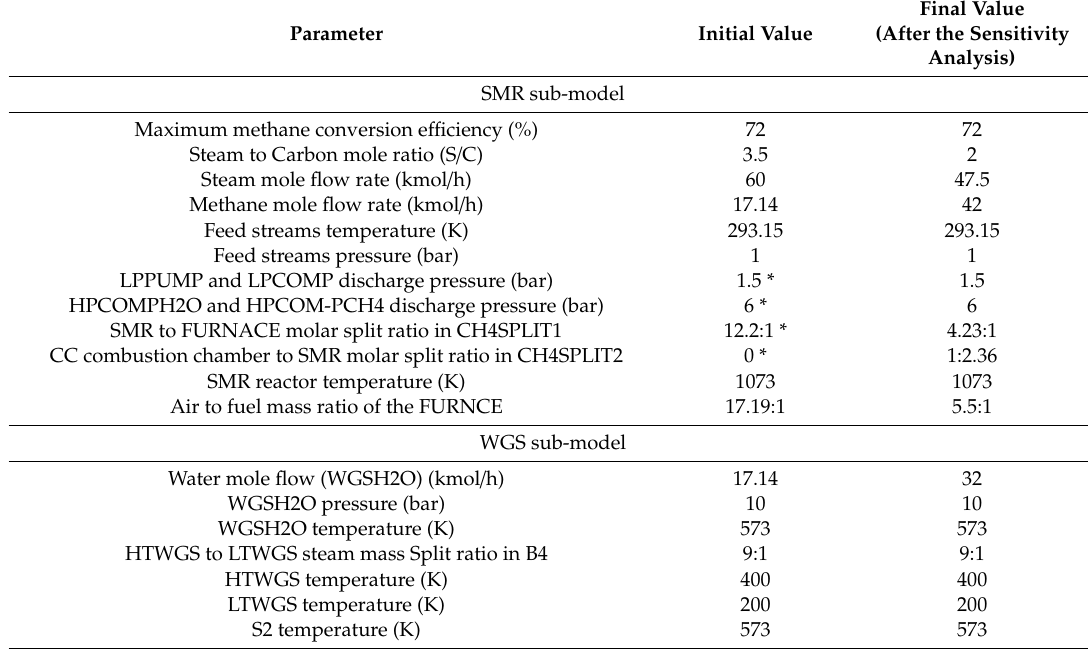
Table 2. Initial and final input